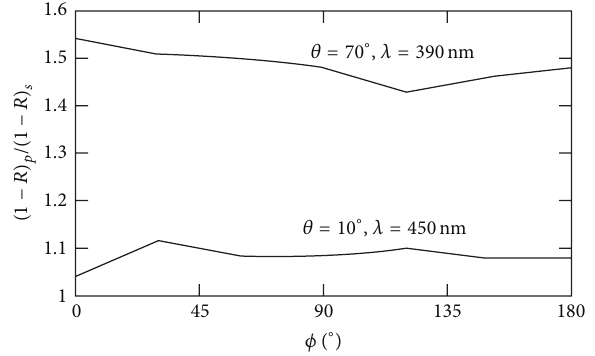
Figure 6: The polarization (1 − 𝑅) ratio (1 − 𝑅) 𝑝 /(1 − 𝑅) 𝑠 versus azimuthal angle for two incident light angles of 10 ∘ and 70 ∘ on helical pentagon shaped Ag sculptured thin